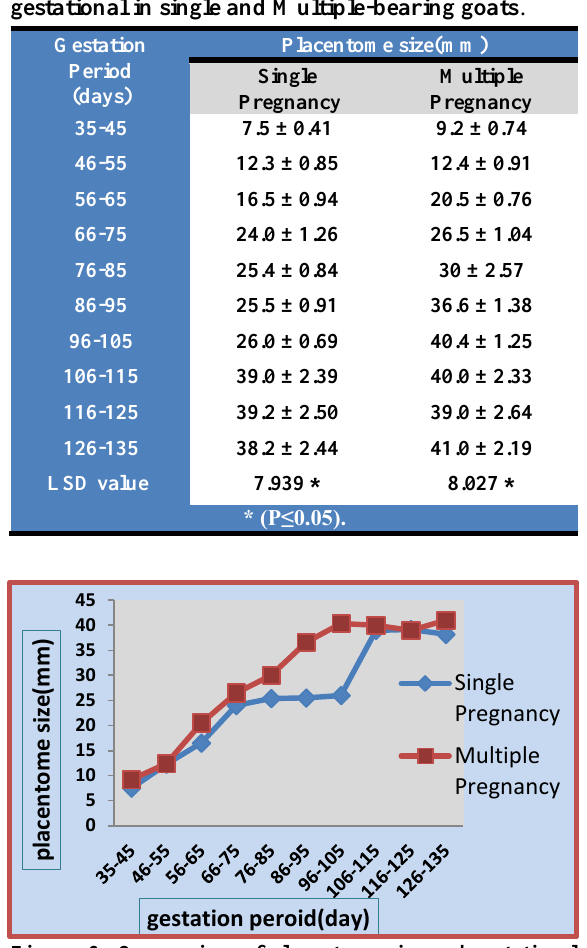
Figure, 6: Comparison of placentome size and gestational age in singleton and twin-bearing